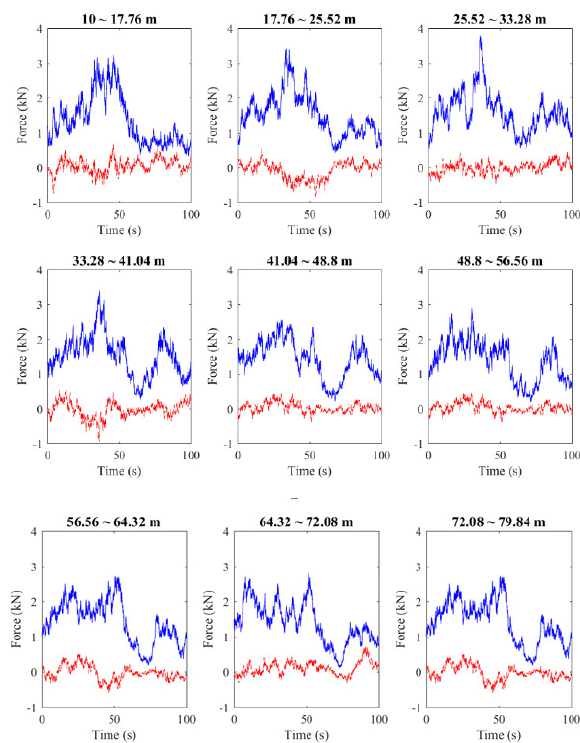
Figure 17. The force on each section of the tower under normal wind conditions (blue line: x direction; red line: y direction).